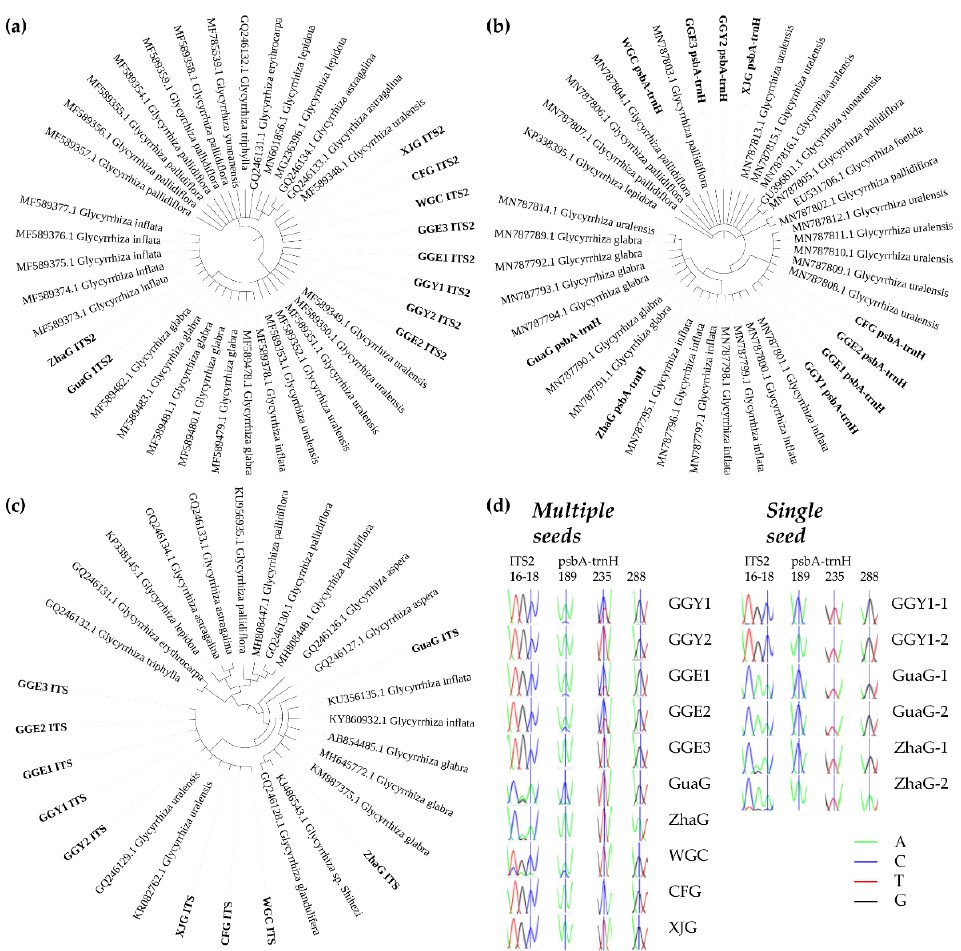
Figure 2. Phenetic tree and chromas file of Sanger sequencing identification results. ( a – c ) are the phylogenetic tree of ITS2, psbA-trnH , and ITS sequences of Glycyrrhiza species, respectively. Sample sequences sequenced by Sanger are shown in bold, and the remaining sequences came from GenBank, preceded by the accession number. ( d ) From left to right are the sanger sequencing peaks of mutation sites in multiple seeds and a single seed, respectively. Each nucleotide is color-coded: A for adenine in green, T for thymine in red, C for cytosine in blue, and finally G for guanine in black.